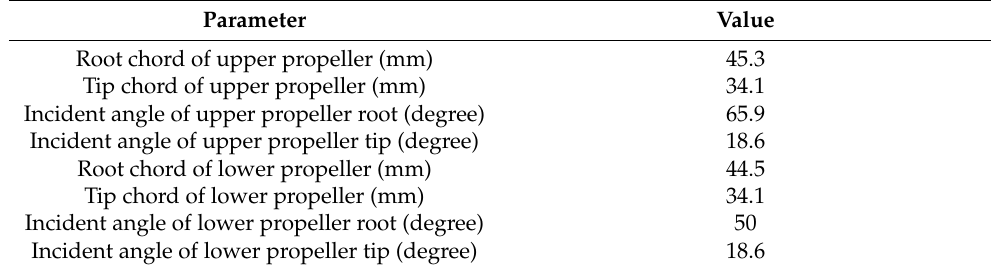
Table 2. Parameters of propellers.